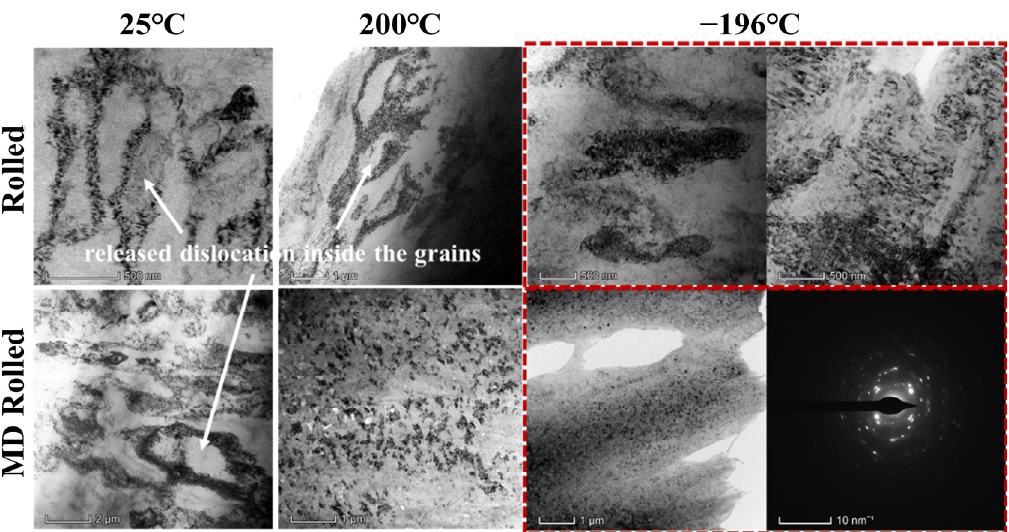
Figure 6. Bright- fi eld TEM images of sub-grains under distinct circumstances. Figure 6. Bright-field TEM images of sub-grains under distinct